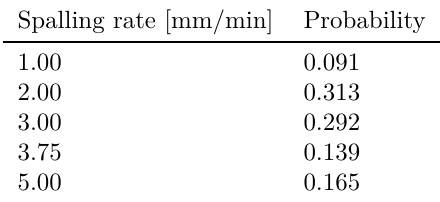
Table 3. Assessment of conditional probabilities for the spalling